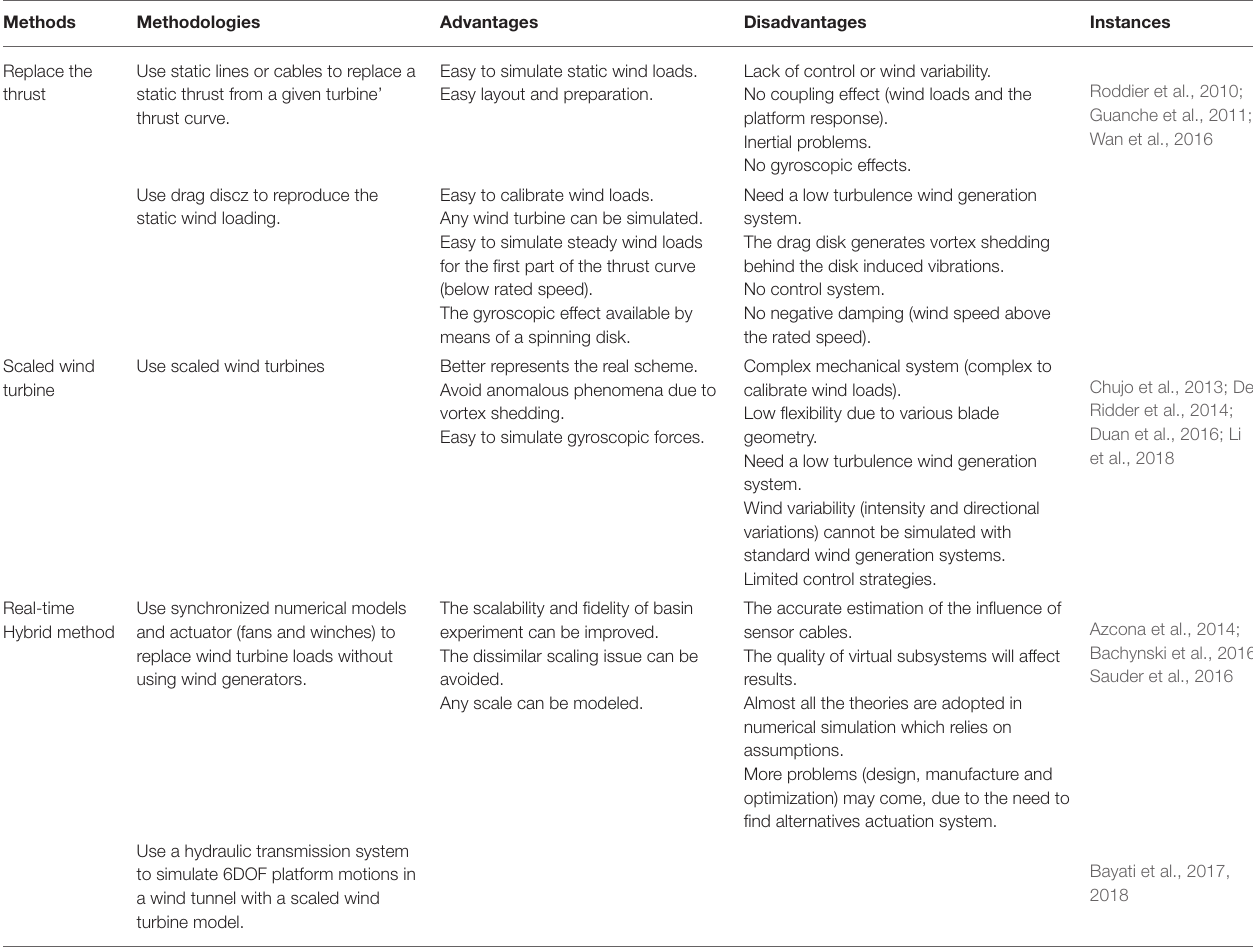
TABLE 1 | Different methodologies to match the wind and wave loads.